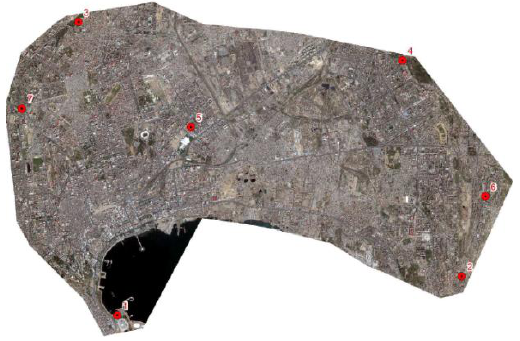
Figure 1. The placement scheme of GPS points